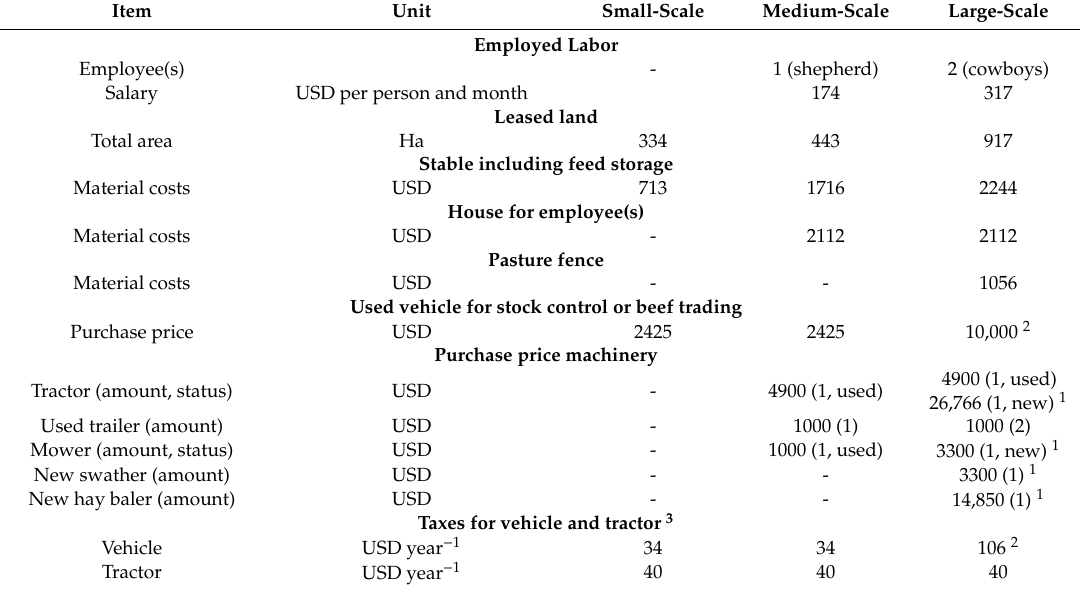
Table 4. Calculation parameters (averages) for fixed costs of three types of individual farms in the Ili Delta for base year